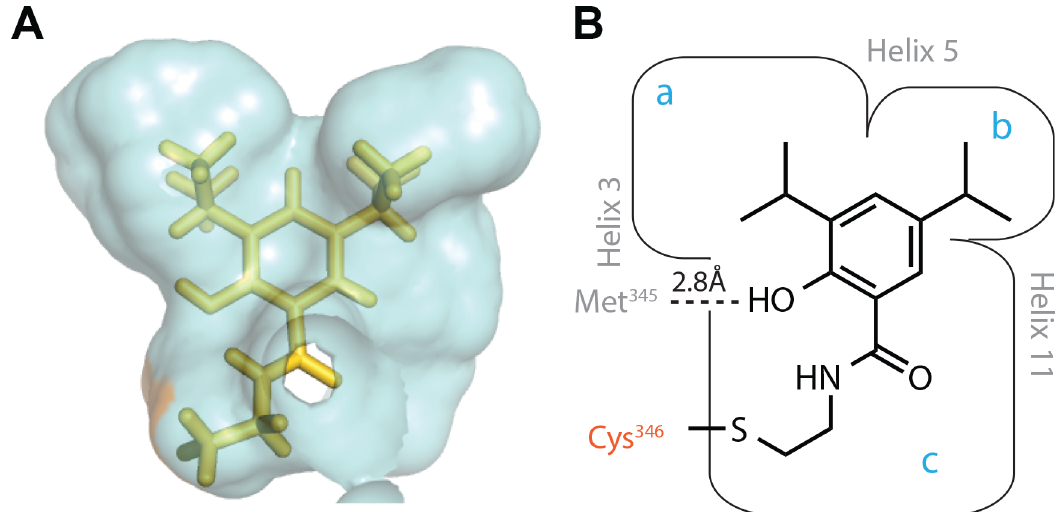
Fig 1. Computational model shows orientation of and space around top hit 15.31 in the hLRH-1 pocket. A. Computational model of top hit 15.31 covalently bound to LRH-1 through a disulfide bond to Cys 346 . Van der Walls surface (blue) represents all protein within 4.5 Å of the ligand. B. Structure of 15.31 and cartoon derived from the model illustrating the binding site for 15.31 is framed by helices 3, 5 and 11 and likely includes a polar interaction with the backbone carbonyl of Met 345